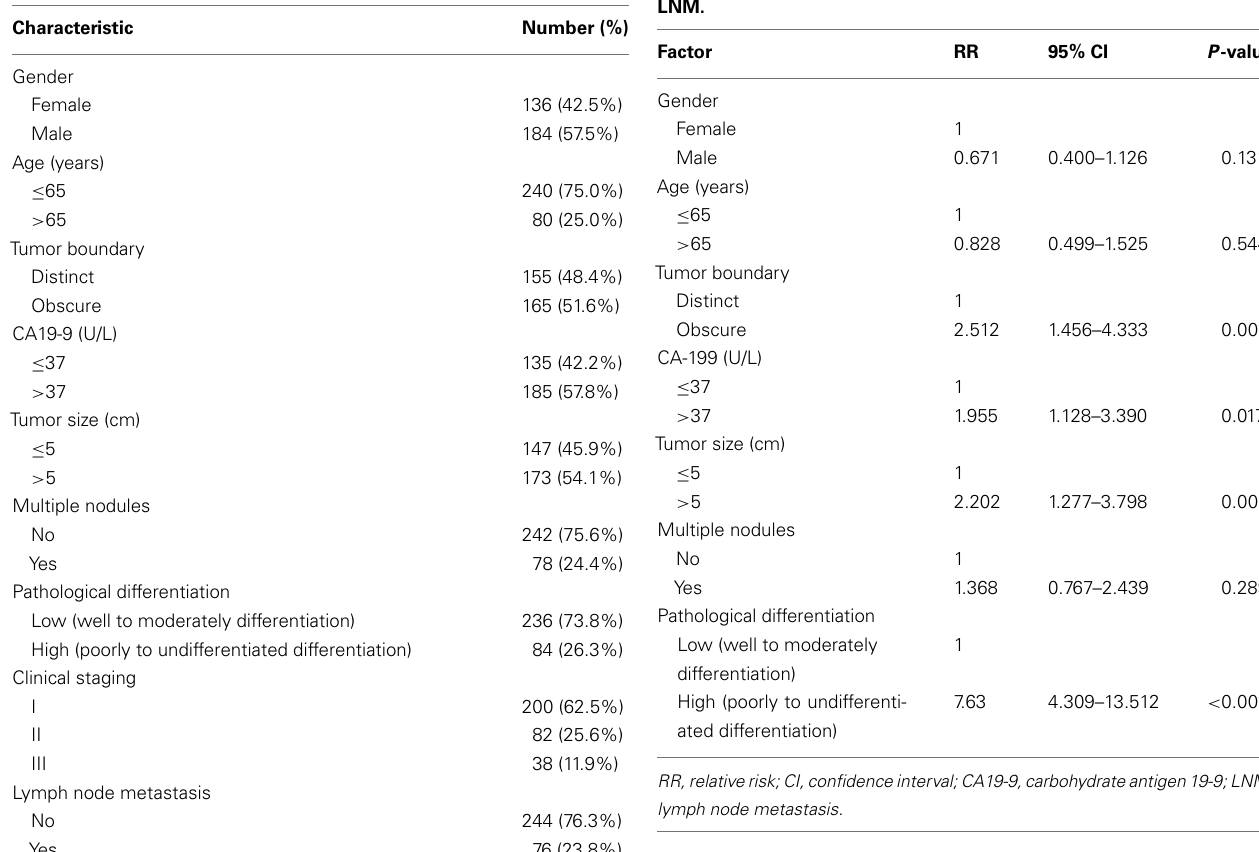
Table 3 | Results of the multivariate analysis of factors associated